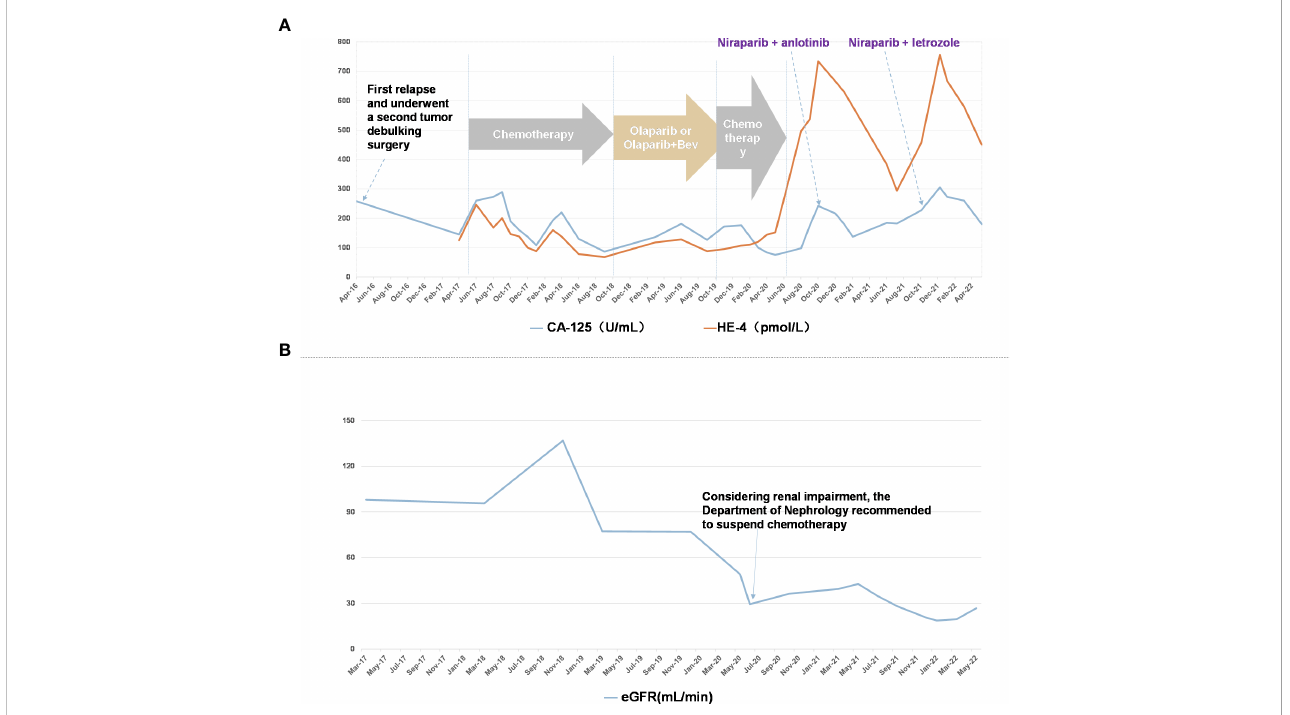
FIGURE 1 Patient course of disease progression and various treatment timelines (A) CA-125 (U/mL) and HE-4 (pmol/L) levels in patient through the timeline Apr 2016 to May 2022. (B) eGFR (mL/min) in patient through the timeline May 2017 to May 2021.